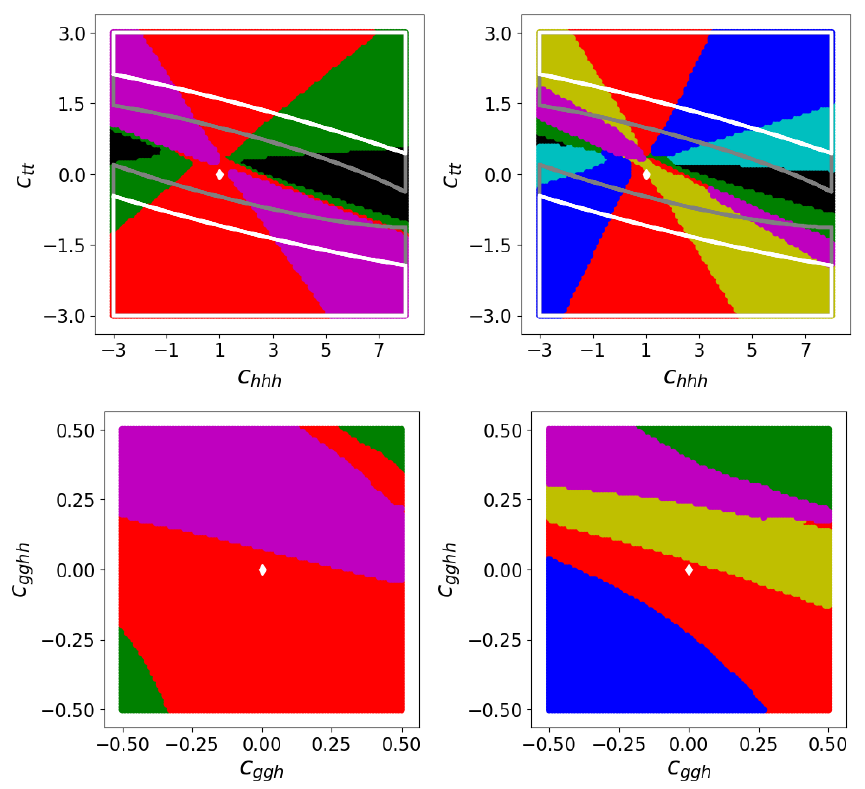
Figure 13 . Shape types produced by variations of c hhh versus c tt (top) and c ggh versus c gghh (bottom). Left: 4 clusters, right: 7 clusters. The areas outside the silver and white curves are regions where the total cross section exceeds 6 : 9 (cid:2) (cid:27) SM and 22 : 2 (cid:2) (cid:27) SM , respectively. These values p are motivated by the current ATLAS/CMS limits at s = 13 TeV [1, 2]. The red areas denote SM-like shapes. The full colour code is given in table 1.